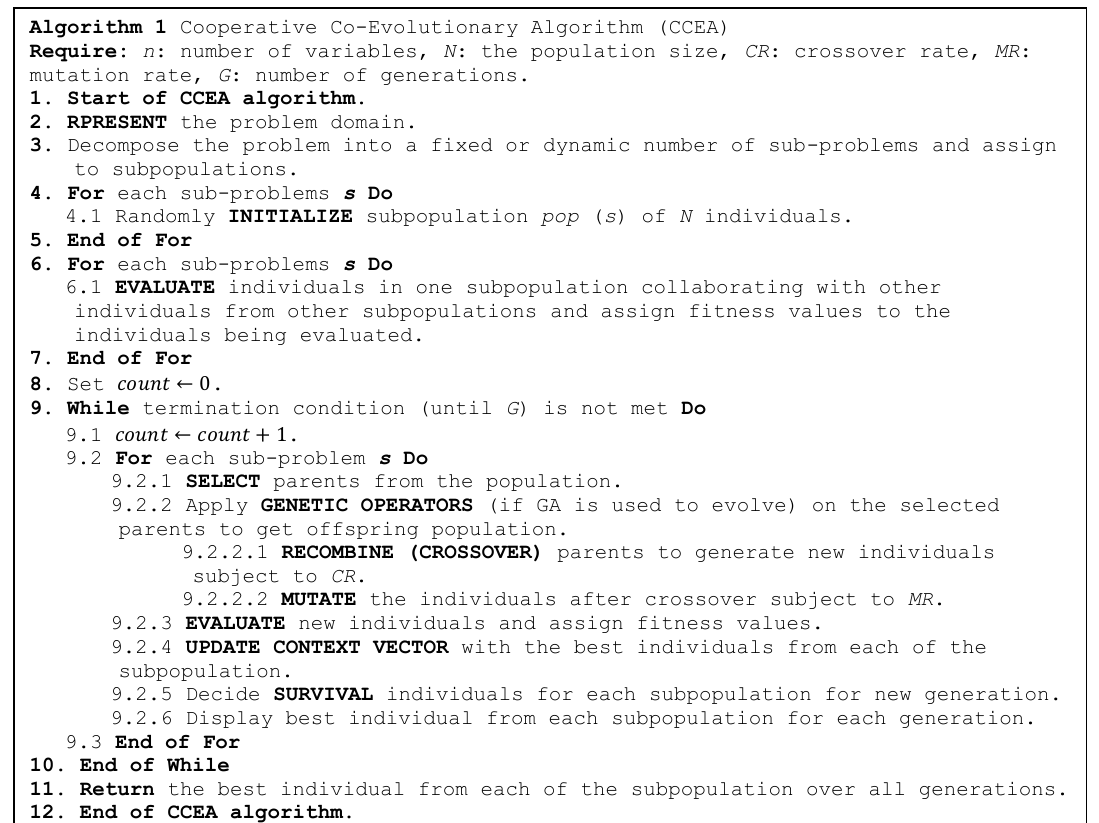
Figure 4. An outline of cooperative co-evolutionary algorithm